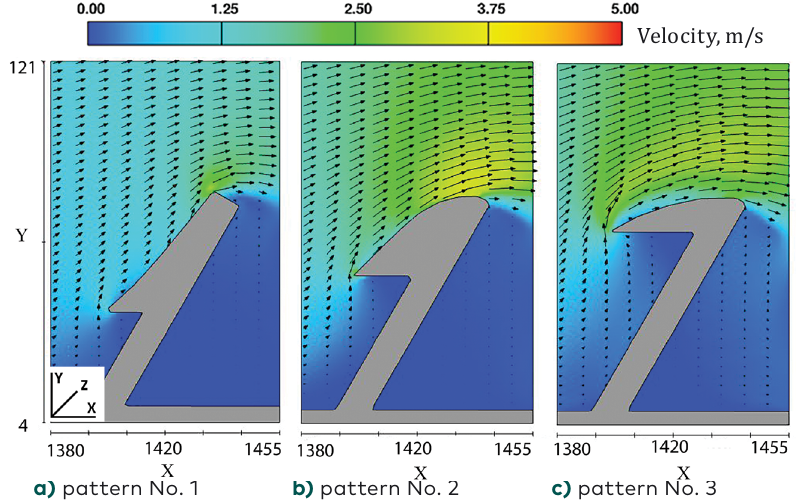
Figure 20. Velocity distribution at the height of 1 m from the floodplain bed for flow-guiding embankment at a 30° skew